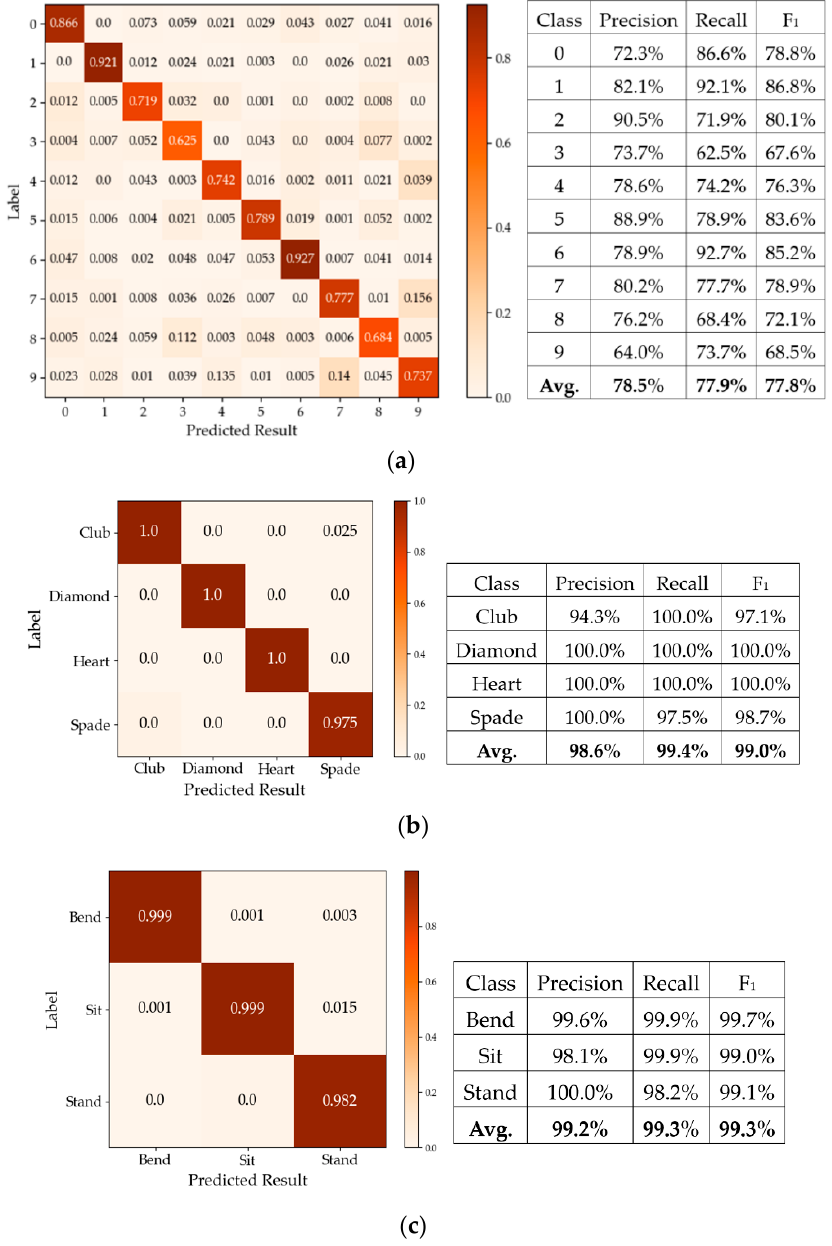
Figure 8. Confusion matrices and precision, recall, F1 metrics for the datasets. ( a ) MINST-DVS, ( b ) Poker-DVS, and ( c ) Posture-DVS.